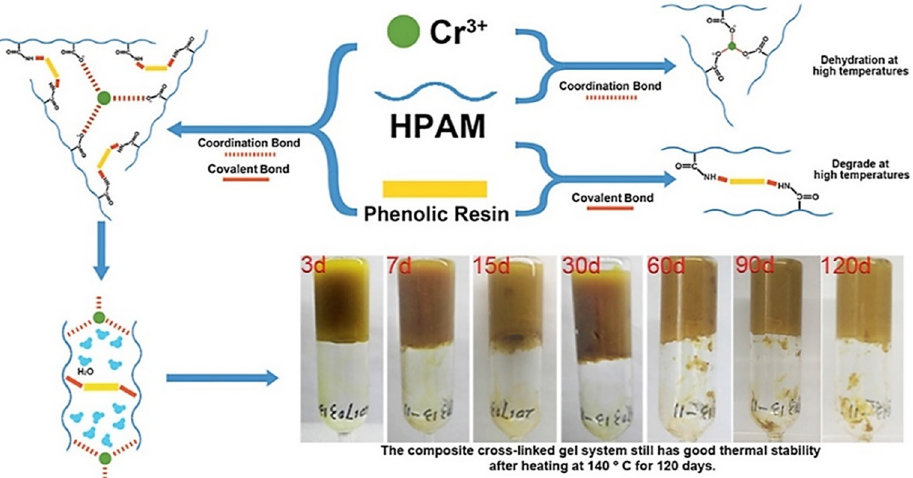
Figure 2. Crosslinking mechanism of Cr (III) and phenolic resin. (Reprinted/adapted with permission from Ref. [29], 2020, Zhang et al.).